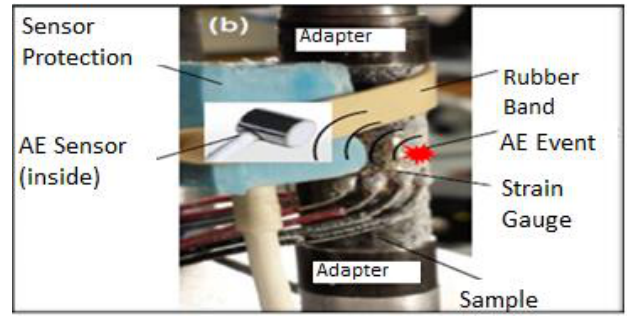
Figure 2. Experimental setup of acoustic emission (AE) equipment used to collect the acoustic events.